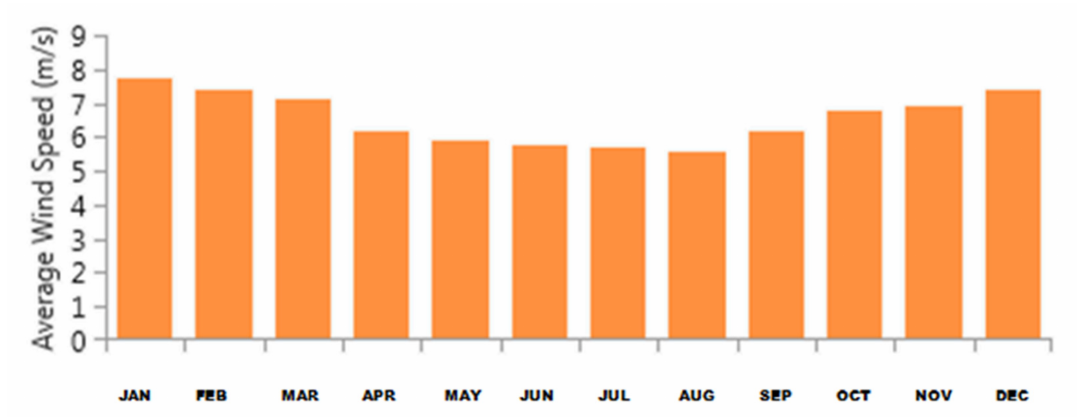
Figure 3. Average wind speeds (m/s) for the Lubuskie Voivodeship. Source: own study using Homer Grid